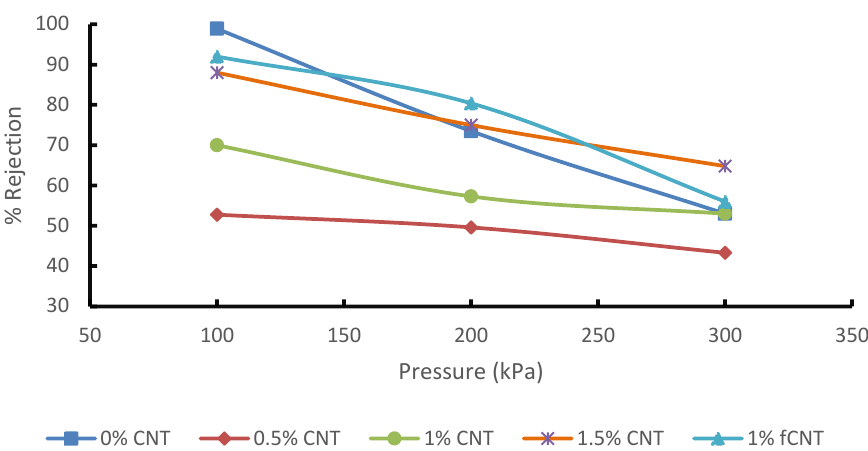
Figure 8. E ff ect of pressure and CNT concentration on phenol Figure 8. Effect of pressure and CNT concentration on phenol rejection.